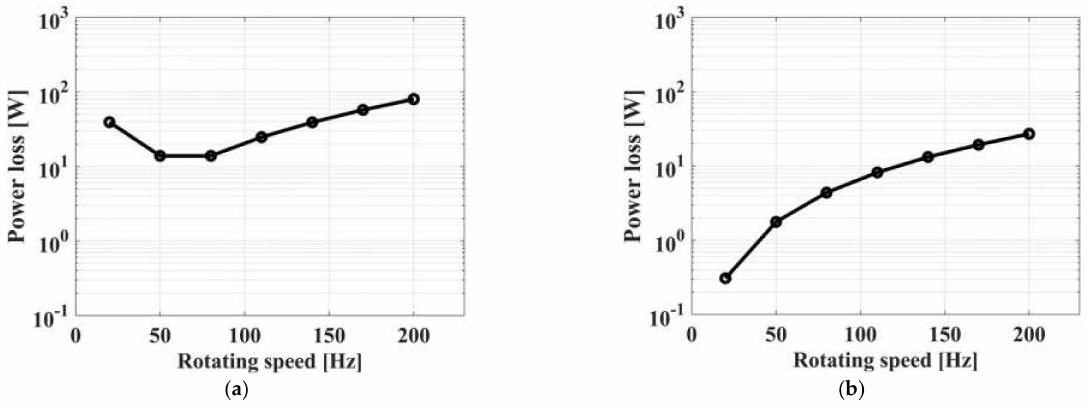
Figure 9. Power loss of an upper bearing ( a ) and lower bearing ( b ).